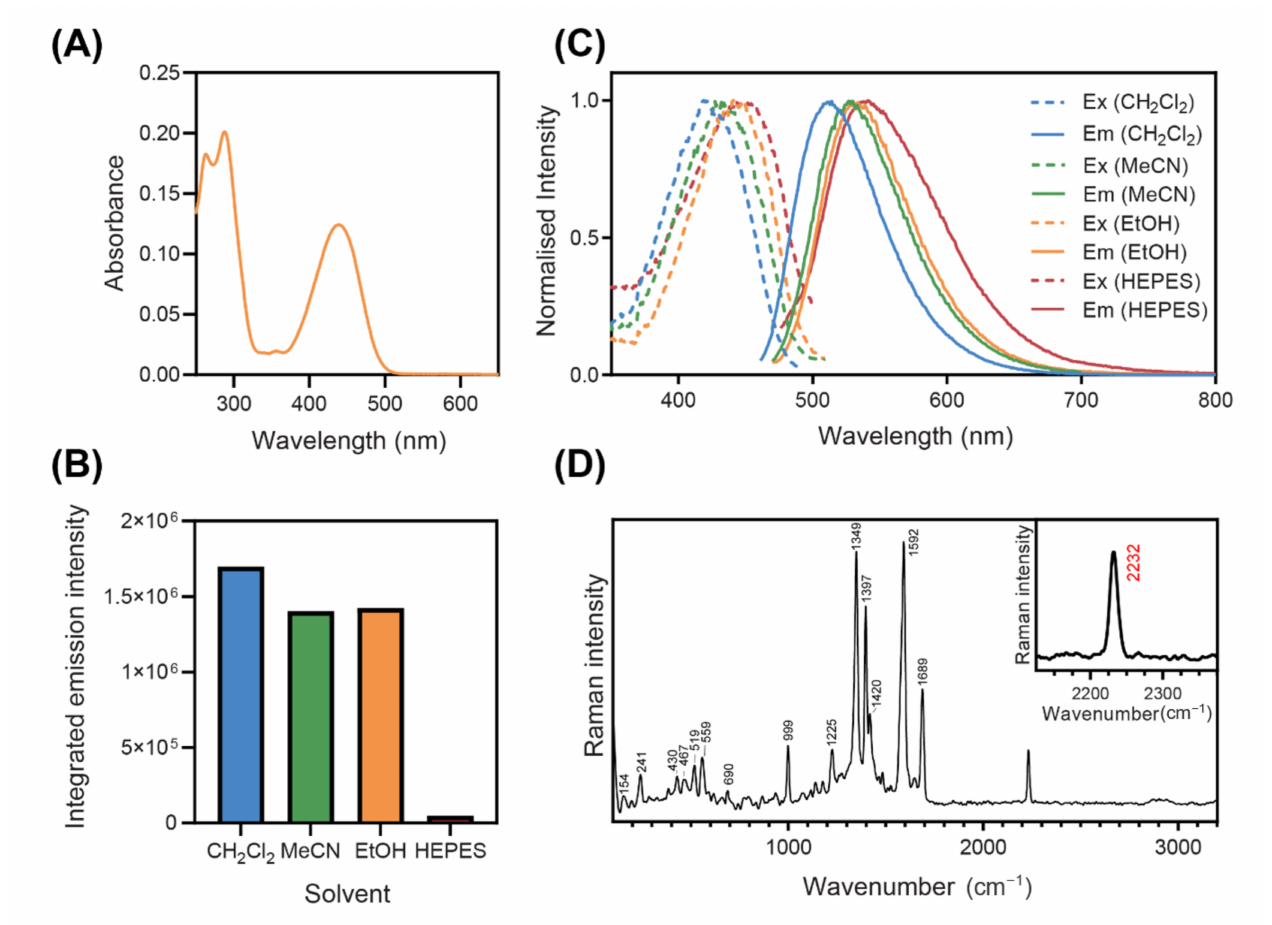
Figure 2. ( A ) Absorbance spectrum of NpCN1 (10 µ M) in absolute ethanol. ( B ) Normalised fluorescence excitation and emission spectra and ( C ) integrated fluorescence emission intensity of NpCN1 (10 µ M) in a variety of solvents; ex = excitation, em = emission, CH 2 Cl 2 = dichloromethane, MeCN = acetonitrile, EtOH = ethanol. ( D ) Raman spectrum of NpCN1 , in the solid state, taken with the 50X and 785 nm laser excitation; inset shows the 2232 cm − 1 C ≡ N band tracked in this